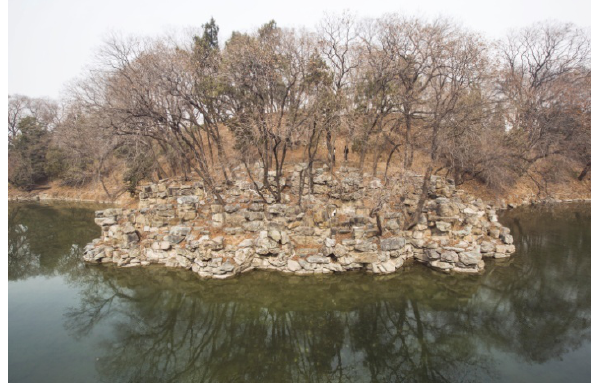
Figure 3. Current situation of the Hall for Watching Cloud Rising